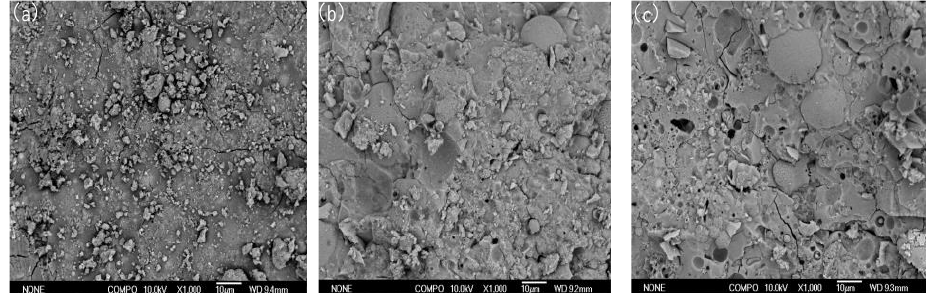
Figure 11. SEM images of samples with different Ms under the C-1 curing conditions after 28-day: